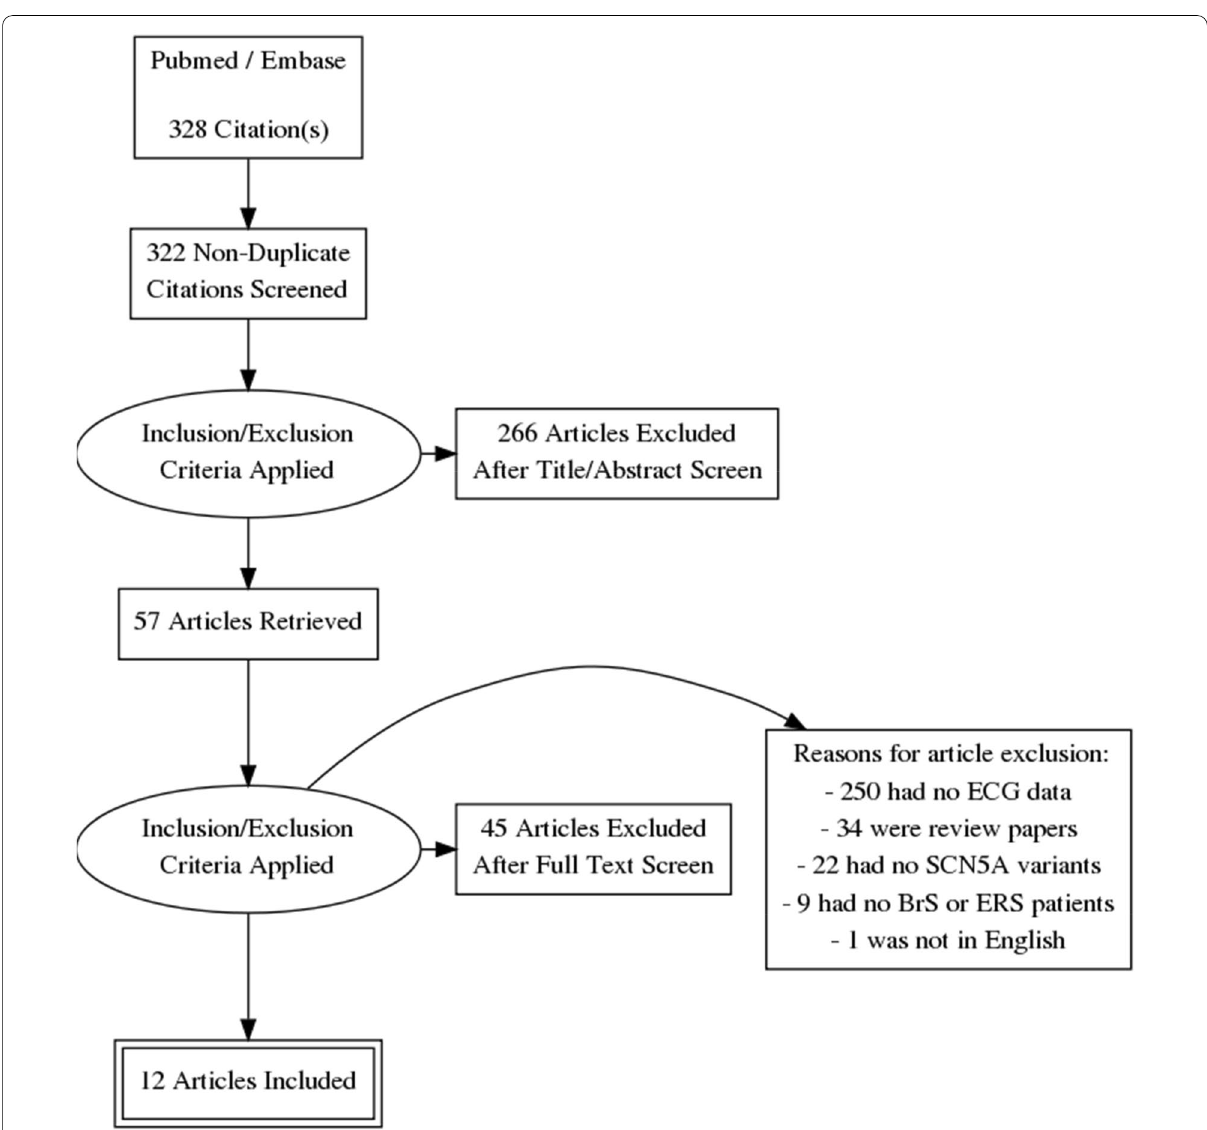
Fig. 1 Flow chart of the study selection